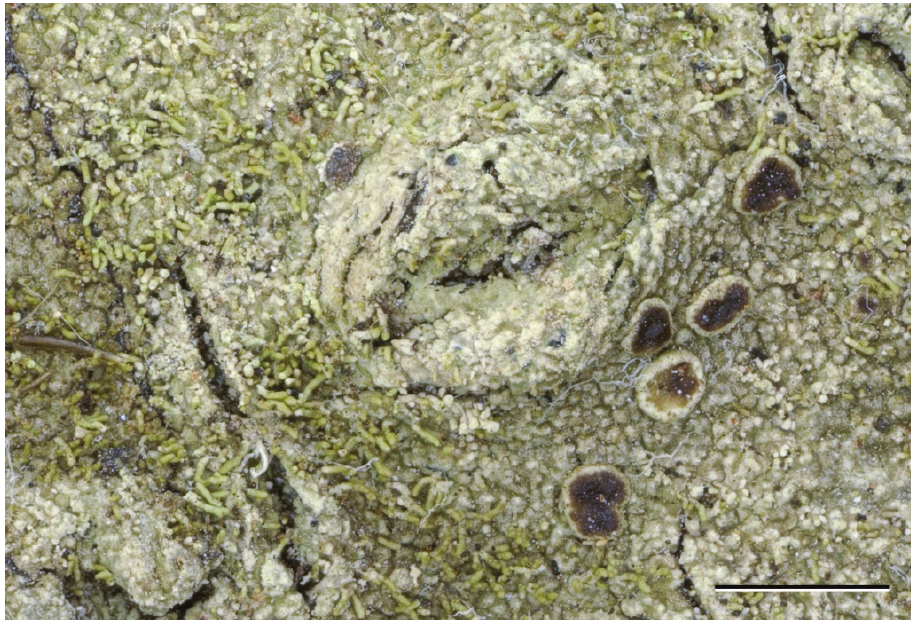
Figure 8. Neoprotoparmelia corallifera (type species Neoprotoparmelia ), sample Papong 7100. Scale bar: 1 mm.